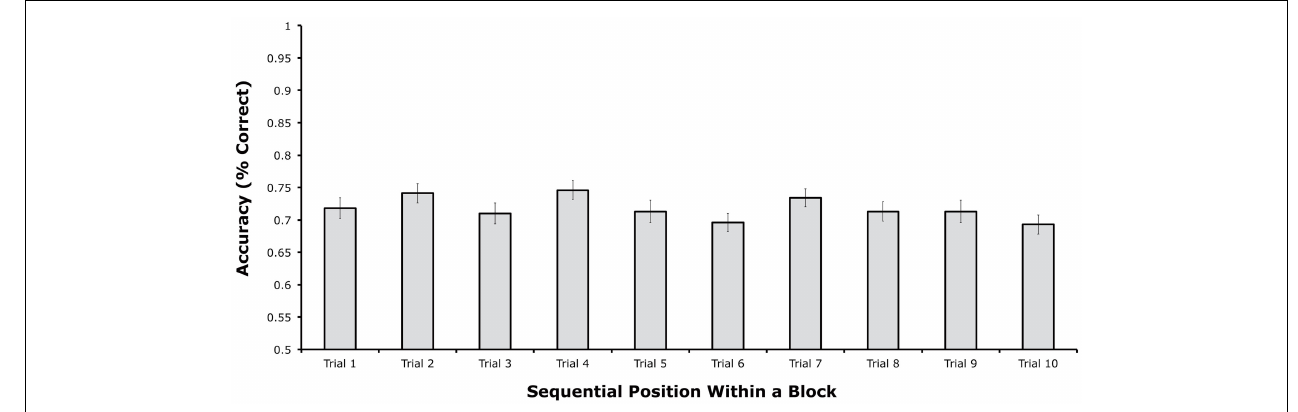
FIGURE 2 | Mean change detection accuracy from each of the 10 sequential positions within a block in Experiment 1 (error bars show 95% within-subjects confidence intervals, as described by Loftus and Loftus,